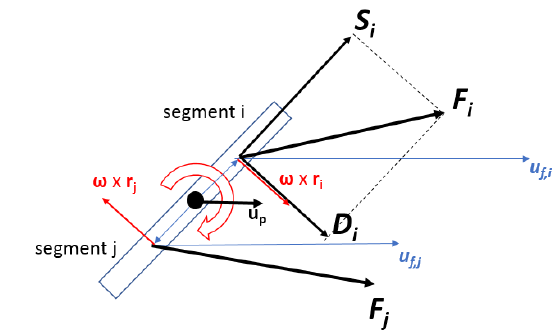
Fig. 2. Forces acting on the fibre during movement in the fluid The relative velocity of the fibre to the velocity of the surrounding fluid is required for evaluation of the forces S i and D i . The velocity of segment i is the sum of fibre translation velocity u p and a contribution from rotation 𝝎 × 𝒓 , where 𝝎 is the angular velocity of fibre 𝑖 around its centre. Inclusion of term 𝝎 × 𝒓 is the 𝑖